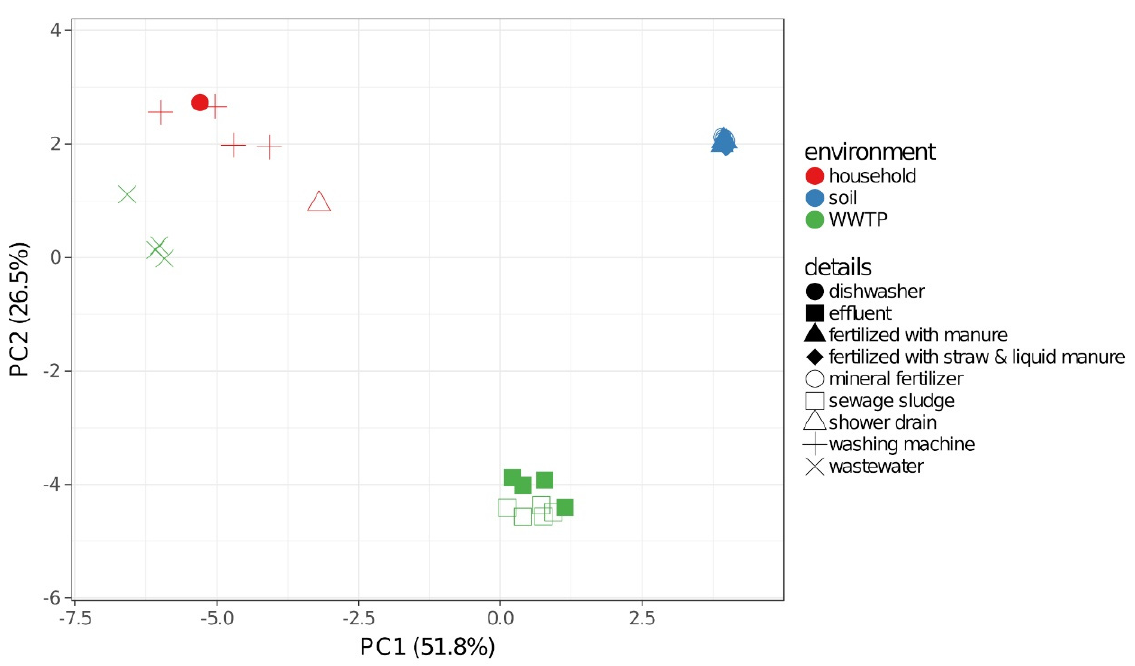
Figure 2. Principal component analysis (PCA) of the beta diversity of different soils, wastewater, sewage sludge, effluent, shower drains, dishwashers and washing machines based on Bray–Curtis dissimilarity. Unit variance scaling was applied to rows and nonlinear iterative partial least squares (NIPALS) PCA was used to calculate principal components. The X- and Y-axis show principal component 1 and principal component 2, which explain 51.8% and 26.5% of the total variance, respectively.